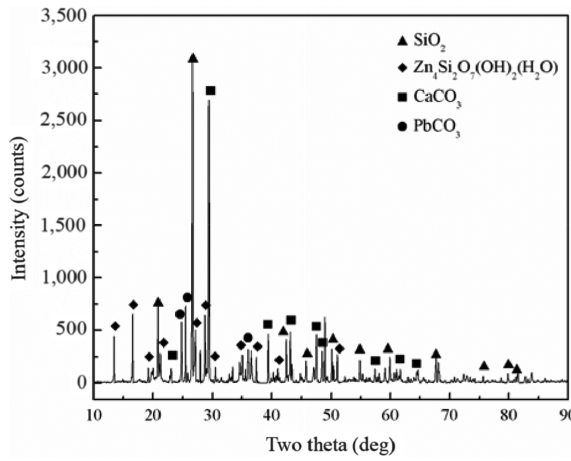
Figure 2: XRD pattern of low-grade oxide zinc ore.